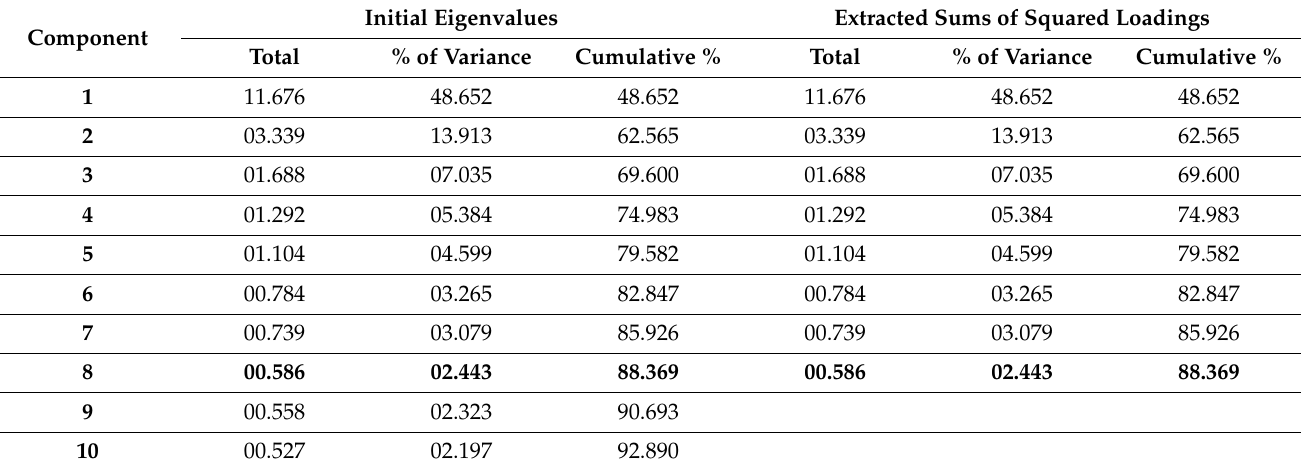
Table 3. The Total Variance Explained including Initial Eigenvalues and Sums of Squared